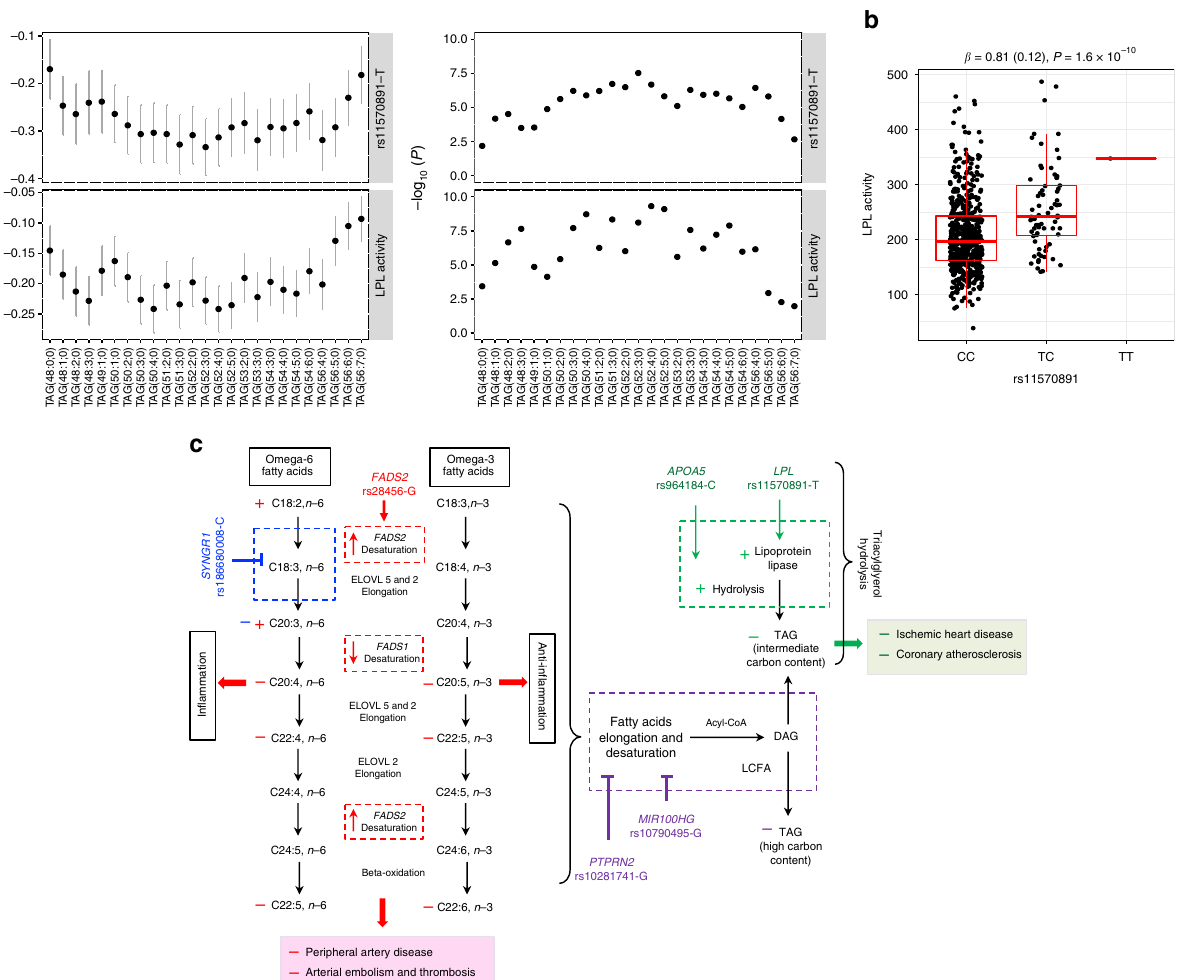
Fig. 6 Patterns in associations and proposed mechanisms for the effect of identi fi ed variants on lipid metabolism and clinical outcomes. a Associations of LPL rs11570891-T and LPL activity with TAGs. Change (beta and standard errors) in plasma levels of TAGs per increase in standard deviation of LPL activity with their corresponding P- values, as calculated using linear regression model, are plotted in lower panel. The upper panel shows change (beta and standard errors) in plasma levels of TAGs per T allele with their corresponding P- values, as obtained from meta-analyses of genome-wide association analysis. b Association of LPL variant rs11570891 with LPL activity. The effect size (beta in standardised units and standard error in parenthesis) and P- value were calculated using linear mixed model. Boxplot depicts the interquartile range (IQR) de fi ned by the bounds of the box, median (middle line) and whiskers extending to the largest/smallest values no further than 1.5 times the IQR. c Based on the patterns of the association of lipid species-associated loci with different lipid species, we propose that: (1) LPL rs11570891-T and APOA5 rs964184-C might result in more ef fi cient hydrolysis of medium length TAGs which might results in reduced CVD risk, (2) FADS2 rs28456-G may have observed effect on PUFA metabolism through its inverse effect on FADS2 and FADS1 expressions, (3) SYNGR1 rs18680008-C might have a role in the negative regulation of either desaturation of linoleic acid (C18:2, n -6) or elongation of gamma linoleic acid (C18:3, n -6). (4) PTPRN2 rs10281741-G and MIR100HG rs10790495-G, which have very similar patterns of association with reduced level of long polyunsaturated TAGs, might have a role in negative regulation of either elongation and desaturation of fatty acids or incorporation of long chain unsaturated fatty acids in glycerol backbone during TAG biosynthesis. The positive ( + ) and negative ( − ) signs indicate increase or decrease, respectively, in level of lipid species or risk of disease as observed in our study, with different colours for different genetic